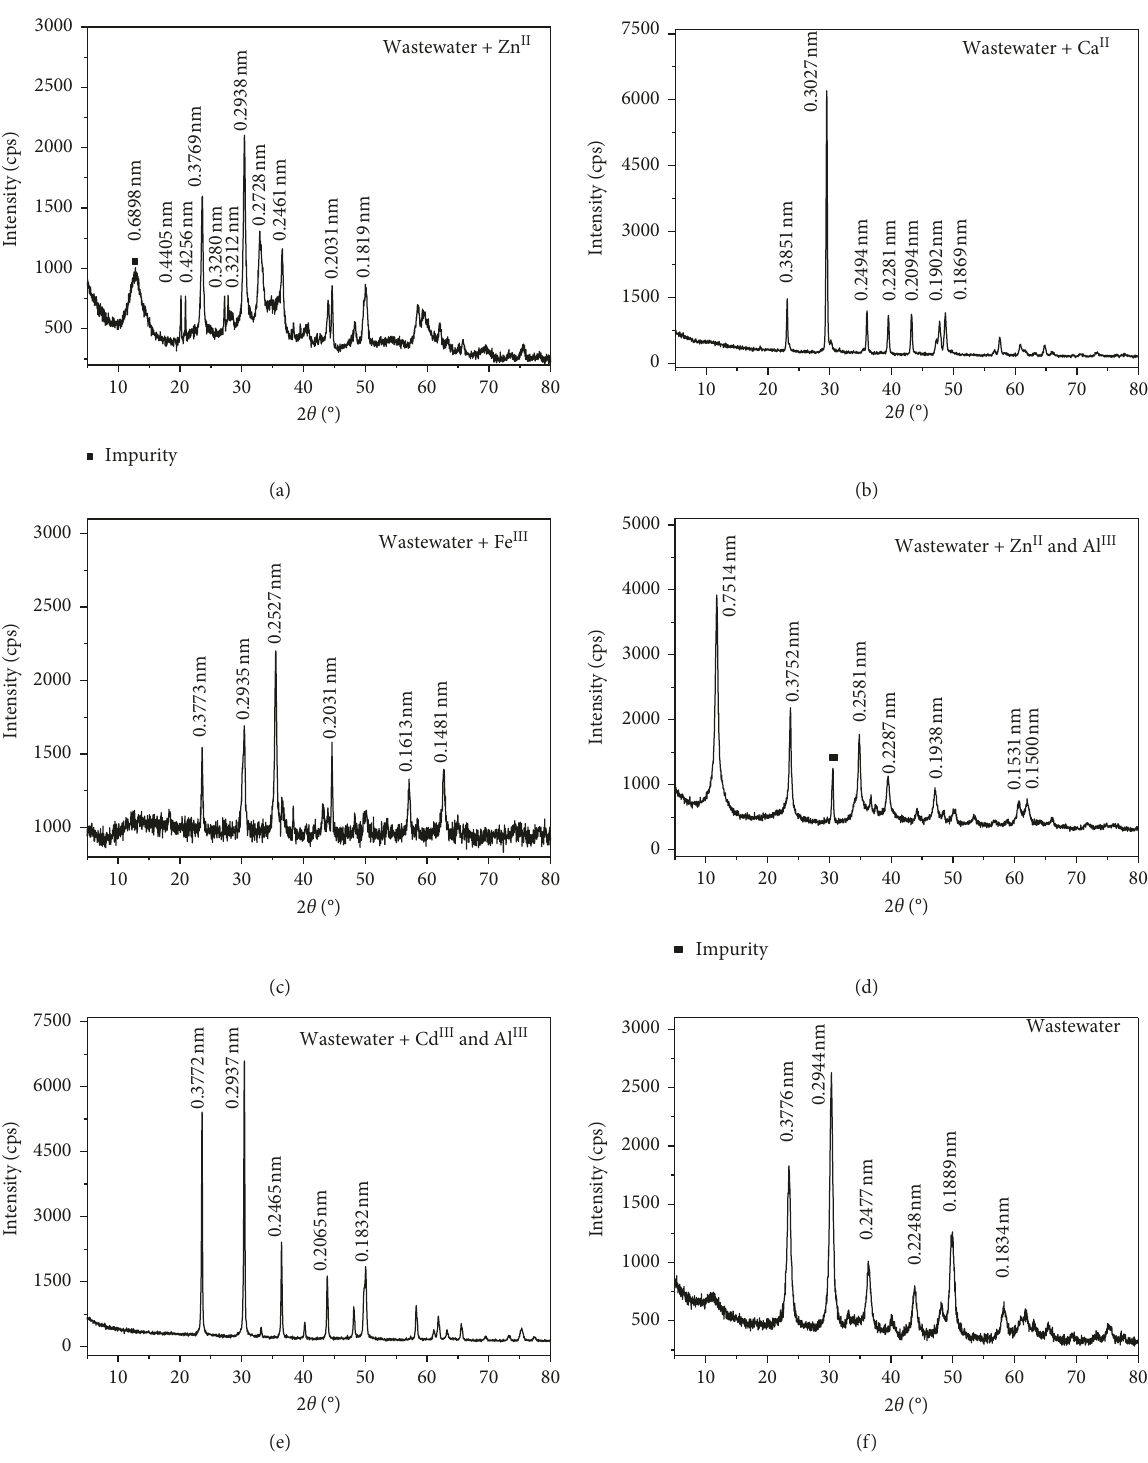
Figure 1: XRD pattern of precipitation of (a) Zn II and wastewater, (b) Ca II and wastewater, (c) Fe III and wastewater, (d) Zn II -Al III and wastewater, (e) Cd III -Al III and wastewater, and (f)